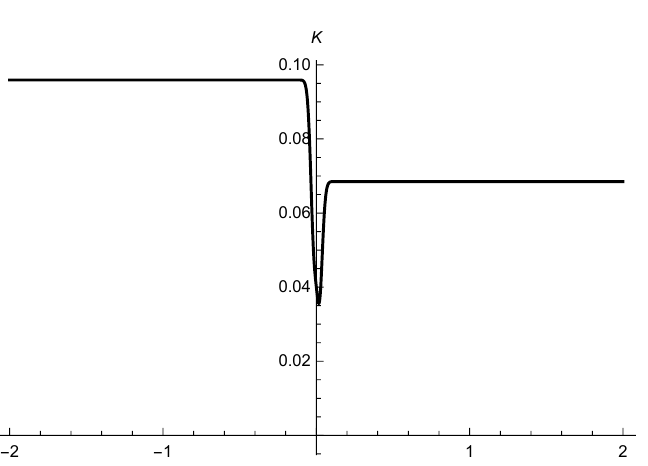
Figure 10. H 3 ( u ) when λ = 0.05.